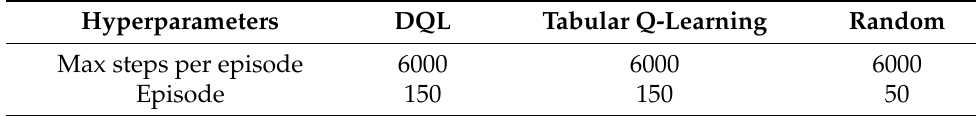
Table 3. Hyperparameter setting of Experiment A.